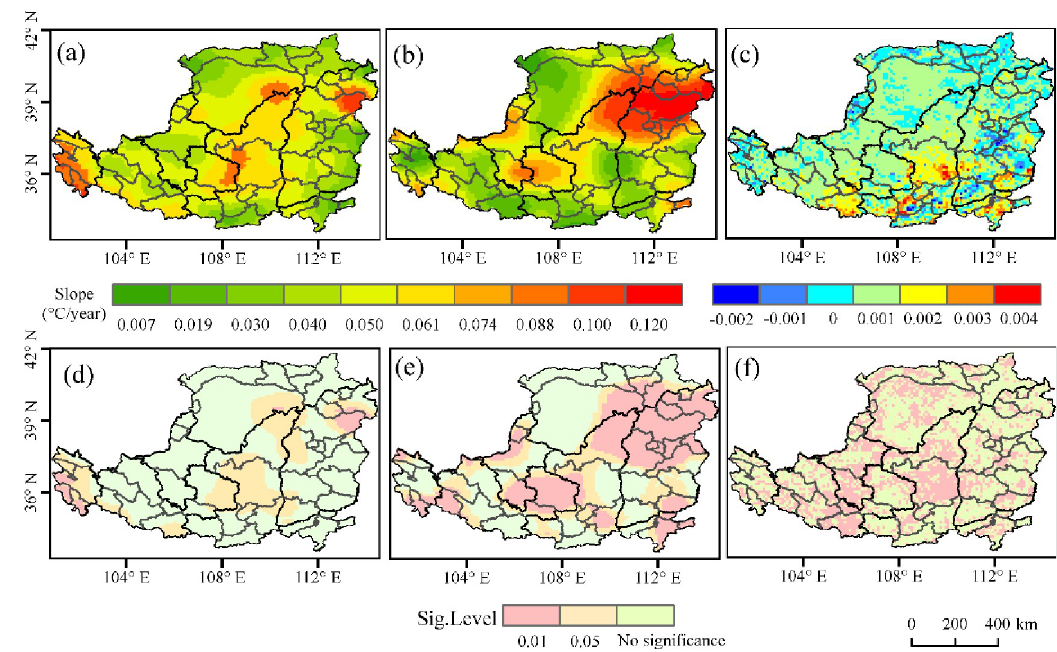
Fig 5. Trends of T max / T min and NDVI in winter over the Loess Plateau from 1982 to 2015. (a) the slope of T max; (b) the slope of T min ; (c) the slope of NDVI; (d) the significance level of T max trends; (e) the significance level of T min trends; and (f) the significance level of NDVI trends. https://doi.org/10.1371/journal.pone.0218480.g005 The different types of NDVI showed partial positive correlations with T and T in max min spring ( p < 0.05) and non-significant partial positive correlations with T in summer max ( p > 0.05). In summer, grasslands and wetlands showed partial positive correlations with T min ( p < 0.05), while other types of NDVI showed non-significant partial positive correlations ( p > 0.05). Except cultivated land, there was a non-significant partial positive correlation between the NDVI and T in autumn ( p > 0.05). In autumn, cultivated land showed signifi- max cant partial positive correlations with T ( p < 0.05), while other types of NDVI showed non- min significant partial positive correlations ( p > 0.05). In winter, cultivated land, forest, and grass- land showed partial positive correlations with T and T ( p < 0.05), shrub showed non-sig- max min nificant partial positive correlations with T and T ( p > 0.05), wetland showed a max min Table 2. Partial correlation coefficients between NDVI and T and T for different vegetation types in different season over the Loess Plateau. max min Season Spring Summer